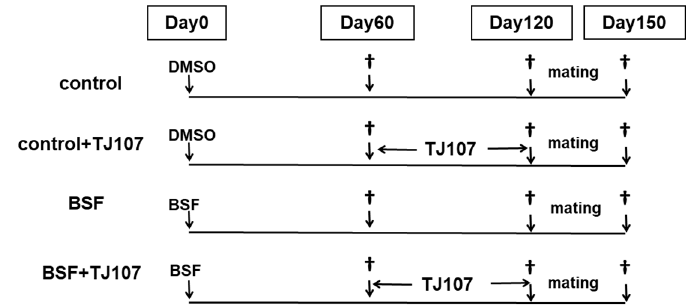
Figure 6. Time schedule of treatment applied to the mice in each group.